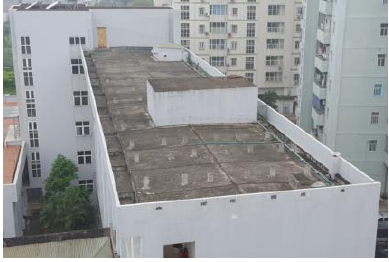
Figure 5. Plan of roof on research building at IGS